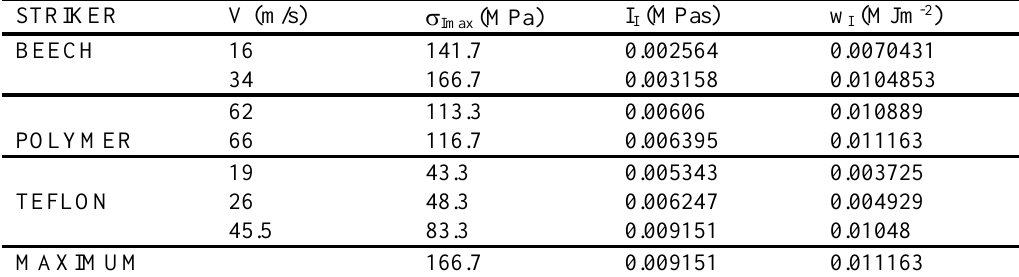
Table 4 . Parameters of the stress pulses recorded for undamaged